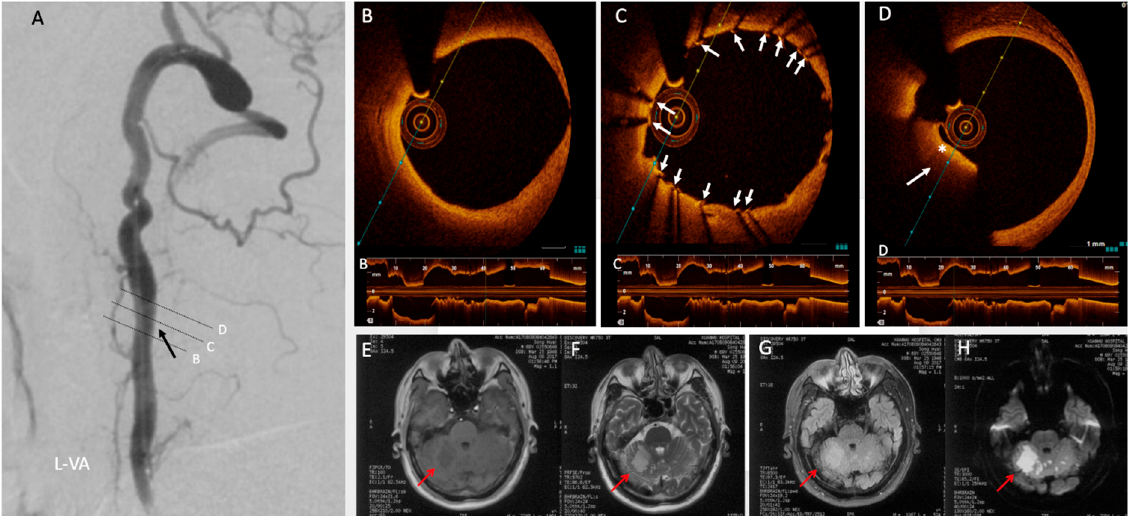
Figure 3. Post-stenting angiography and OCT images and post-procedural MRI. ( A ) DSA of the left V2 segment post-stenting showed marked improvement in previously severe stenosis, well-covered by the stent (black arrow). Cross-sectional OCT images during standard pullback demonstrating ( B ) normal lumen proximally with no thrombus and ( C ) satisfactory stent wall apposition (white arrow), whereas ( D ) distally a hyper-reflective area (*) projecting into the lumen with apparent posterior shadowing indicated red thrombus (white arrow) attached, which had no stent coverage on OCT, suggesting embolization risk. ( E–H ) MRI images following intervention when the patient developed clear symptoms demonstrate right cerebellar infarction (red arrow), presumed to be related to red thrombus, which was not covered.